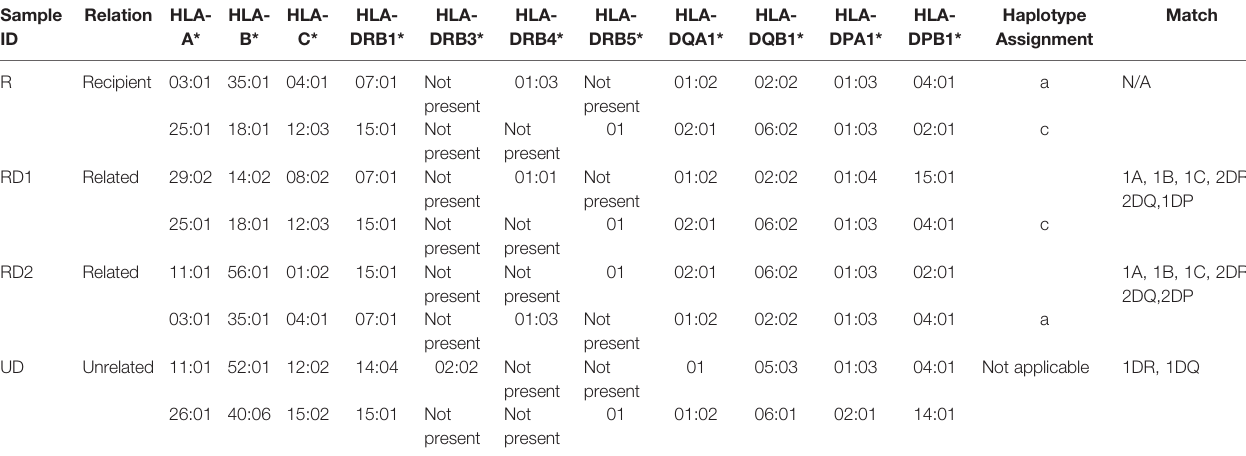
TABLE 2 | HLA-typing results of recipient, related donors, and unrelated donor. Sample